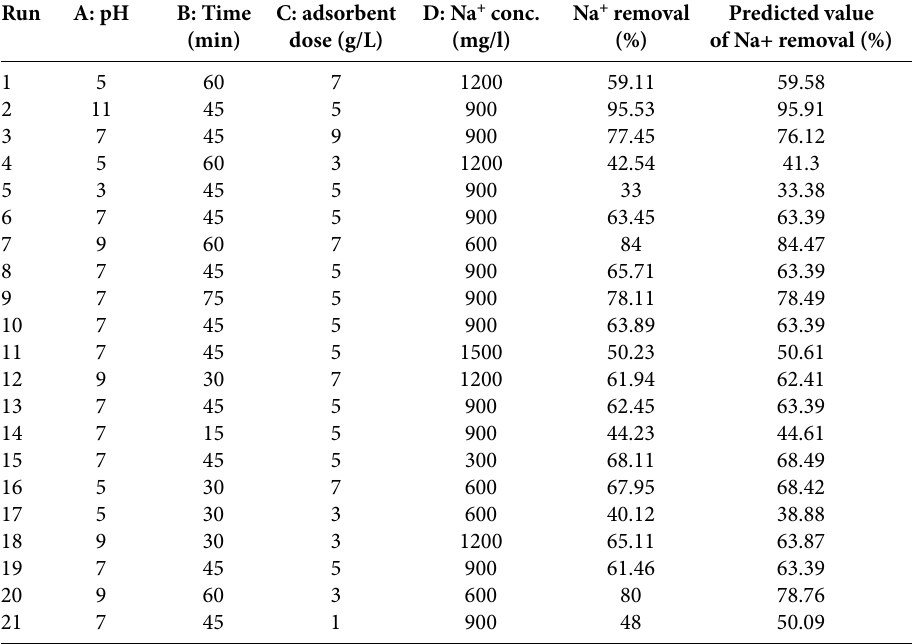
Table 2. The impact of independent variables on the removal efficiency of sodium using AC. Experimental design was done by CCD method Run